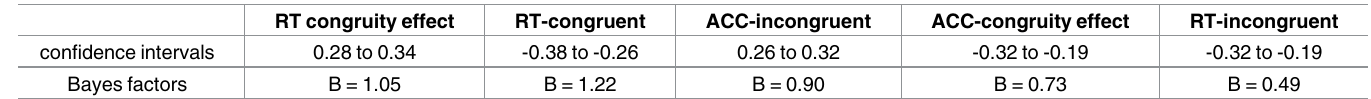
Table 4. 95% confidence intervals and Bayes